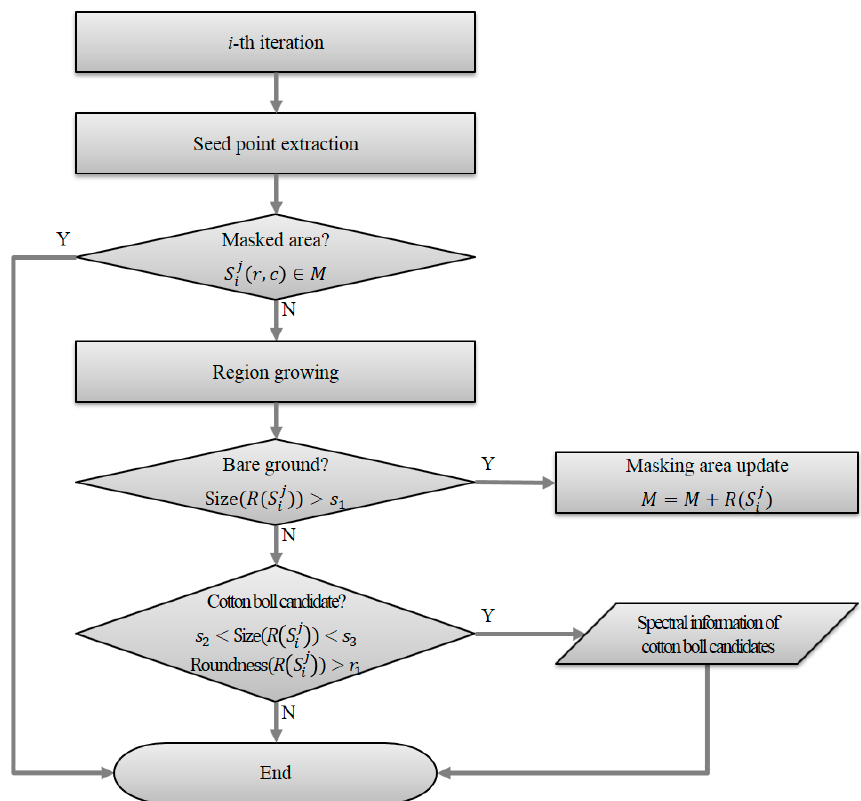
Figure 2. Cotton boll candidate selection.